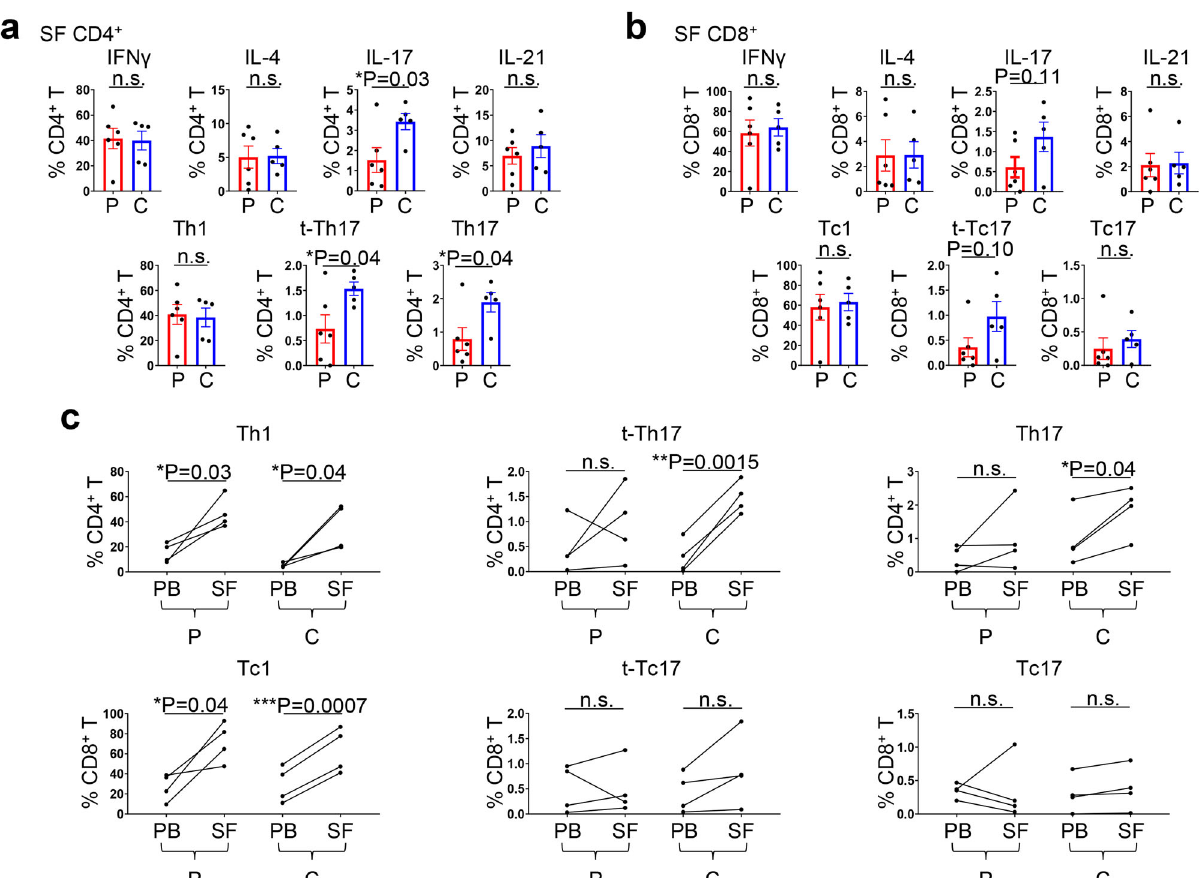
Fig. 5 Th17 cells are enriched in the synovial fl uid (SF) of patients who develop arthritis after combined immune checkpoint inhibitor (ICI) therapy. a Percentage of CD4 + T cells in SF producing key effector cytokines (upper panels) and percentage of Th1, transient (t-)Th17, and Th17 cells (lower panels). Two-sided unpaired t test. * P < 0.05. Bars indicate the mean and SEM. IFN γ , interferon gamma; IL, interleukin. See Supplementary Table 2 for demographic and clinical pro fi les of patients who developed arthritis after PD-1 inhibitor monotherapy (PD-1 inhibitor arthritis; P in the fi gure) and patients who developed arthritis after combined CTLA-4 and PD-1 inhibitor therapy (combined ICI arthritis; C in the fi gure). n = 6 from the PD-1 arthritis group and 5 from the combined ICI arthritis group. b Percentage of CD8 + T cells in SF producing key effector cytokines (upper panels) and percentage of Tc1, t-Tc17, and Tc17 cells (lower panels). Two-sided unpaired t test. Bars indicate the mean and SEM. n = 6 from the PD-1 arthritis group and 5 from the combined ICI arthritis group. c Frequencies of Th1/Tc1, t-Th17/t-Tc17, and Th17/Tc17 cells in 4 peripheral blood (PB) and matching SF samples. Two-sided paired t test. Source data are provided as a Source Data fi